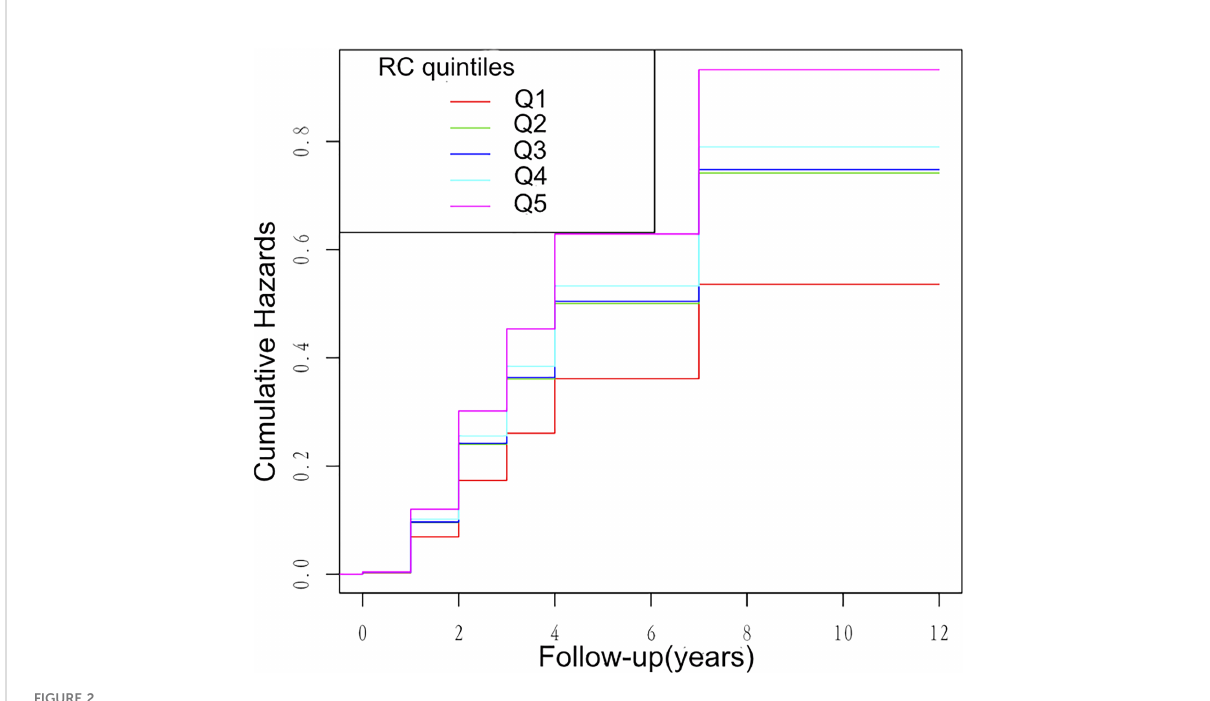
FIGURE 2 Kaplan – Meier analysis between RC quintiles and HTN